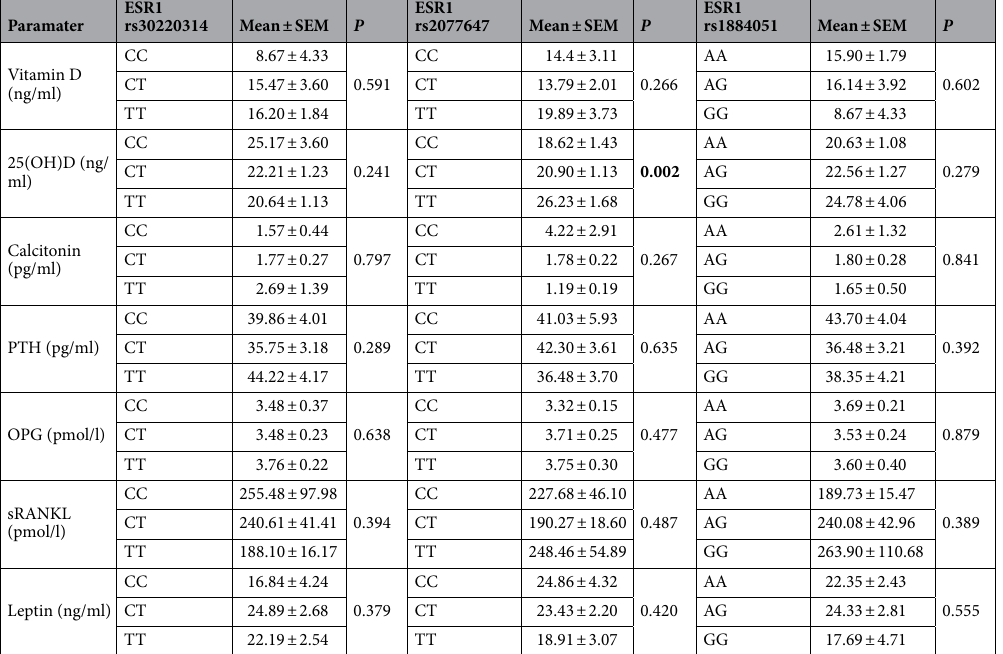
Table 4. Analysis of bone metabolism parameters in relation to ESR1 gene polymorphisms in patients with hyperandrogenism. 25(OH)D 25-OH vitamin D, PTH Parathormon, OPG osteoprotegerin, sRANKL soluble receptor activator of nuclear factor-kB ligand. Significant values are given in